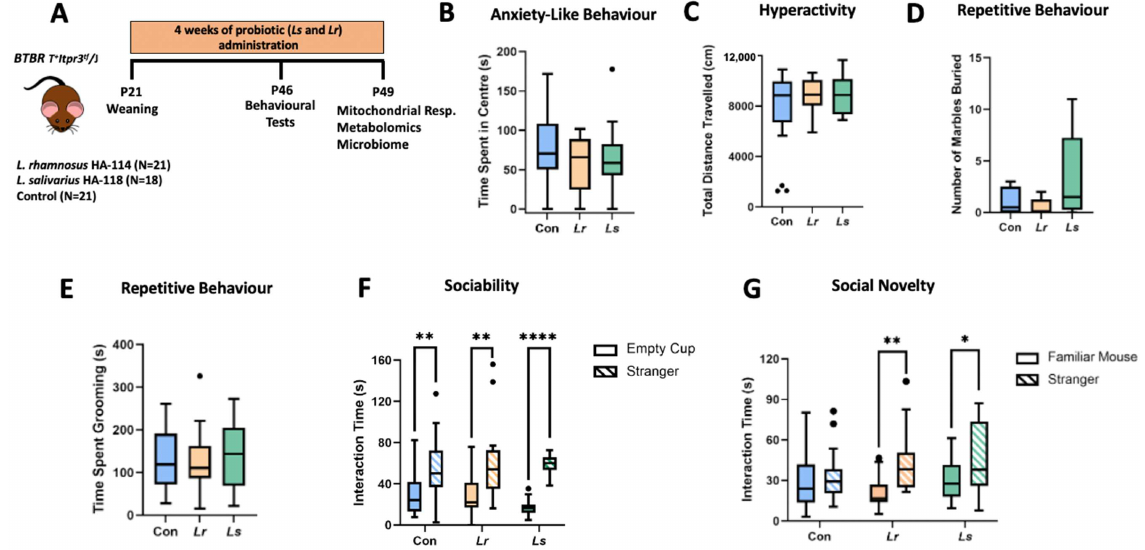
Figure 1. Effects of probiotic treatment on behavioural deficits associated with ASD in BTBR mice. ( A ) A schematic diagram of the experimental design. ( B – F ) A behavioural test battery was performed looking at nonsocial anxiety behaviours (N = 17–21) ( B ), hyperactivity (N = 16–21) ( C ), repetitive behaviours (N = 11–20) ( D , E ) and sociability/social novelty (N = 14–19) ( F , G ) between groups. Con—Control; Lr — L. rhamnosus HA-114; Ls — L. salivarius HA-118. Boxes extend from the 25th to 75th percentiles with the whiskers representing the furthest point that is within 1.5 times the interquartile range (IQR). * p < 0.05; ** p < 0.01, **** p < 0.0001.